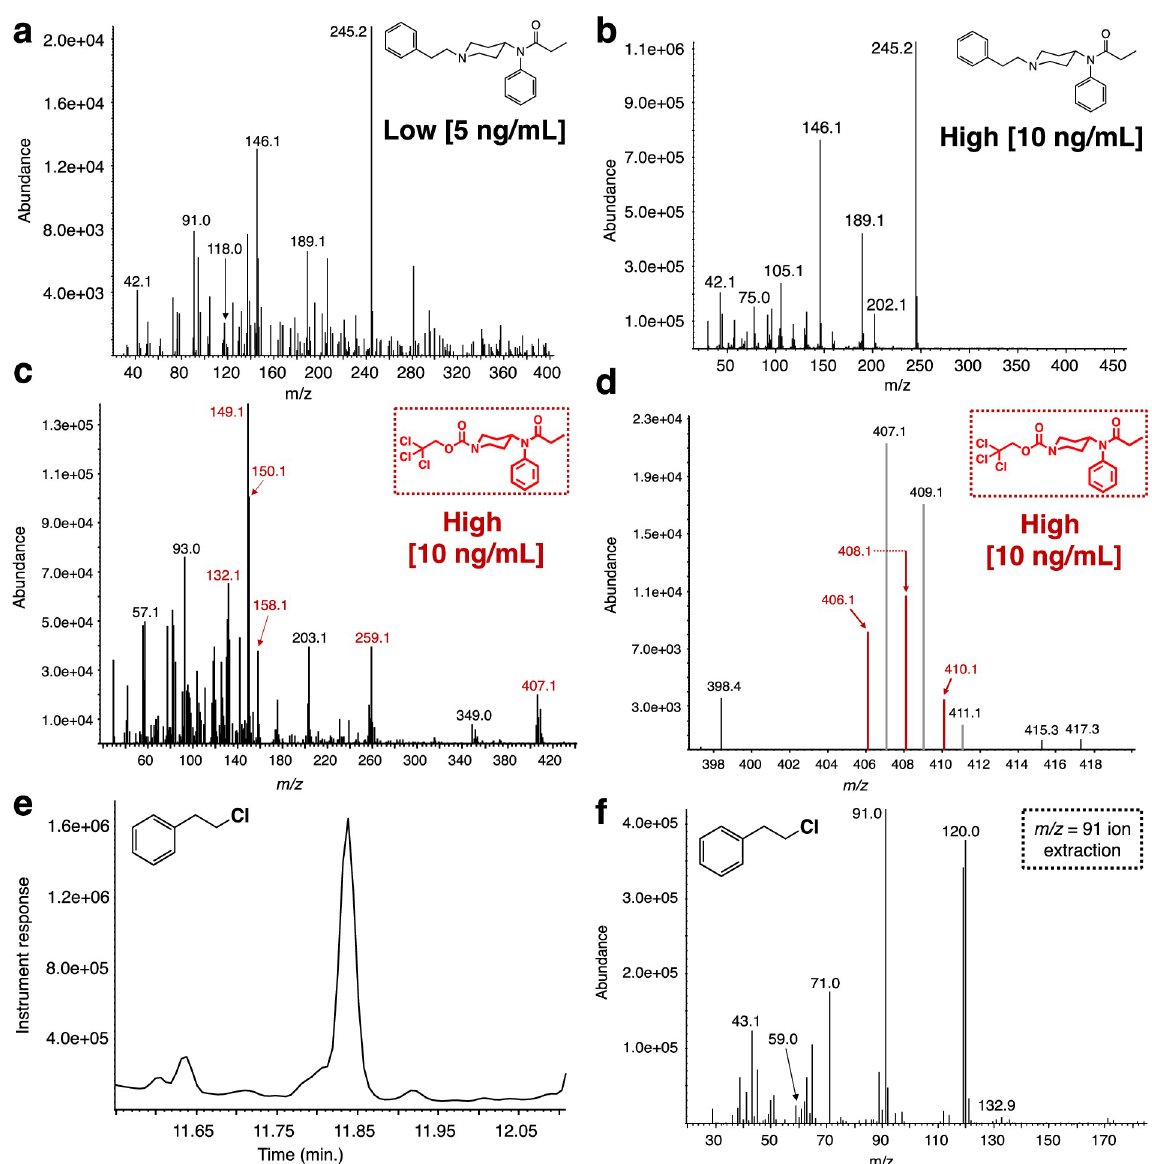
Fig 6. Mass spectral data associated with the reaction between fentanyl-spiked urine matrices with Troc-Cl. Mass spectra for (a) extracted fentanyl when spiked at 5 ng/mL; (b) extracted fentanyl when spiked at 10 ng/mL; (c) mass spectrum of Troc-norfentanyl product arising from the treatment of fentanyl-spiked urine extract (10 ng/mL) with Troc-Cl; (d) expansion of molecular ion peak for Troc-norfentanyl; (e) 2-phenylethyl chloride, the second confirmatory by-product from the Troc-Cl reaction; (f) mass spectrum of 2-phenylethyl chloride containing interfering signals from other matrix